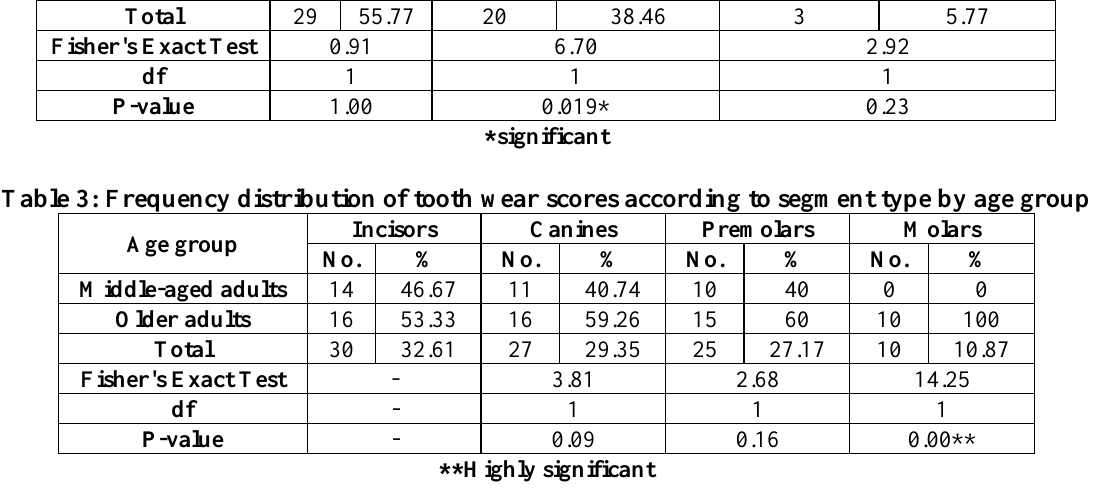
Table 4: Frequency distribution of subjects according to the highest score of tooth wear by age Age group